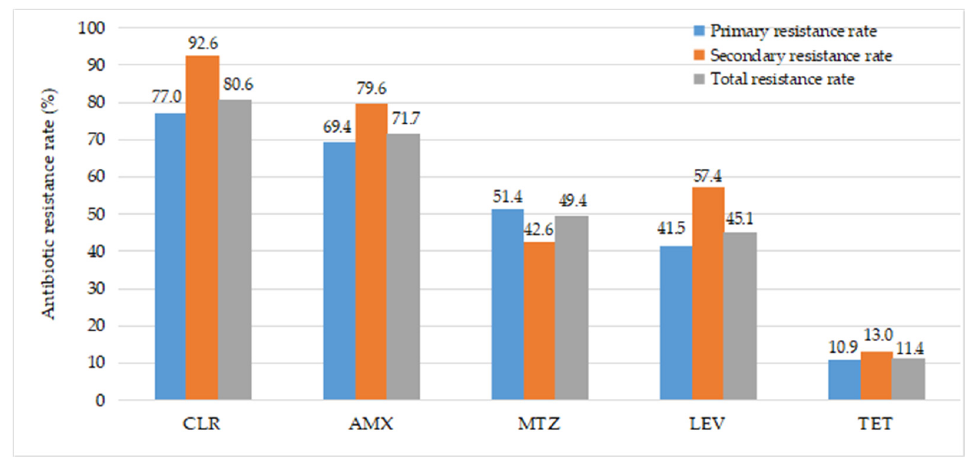
Figure 1. The frequency of H. pylori antibiotic resistance in Vietnamese pediatric patients. CLR, clarithromycin; AMX, amoxicillin; MTZ, metronidazole; LEV, levofloxacin; TET, tetracycline. Among 237 H. pylori strains from pediatric patients, no strains were sensitive to all five antibiotics; 10.1% (24/237) had mono resistance, 32.9% (78/237) had dual